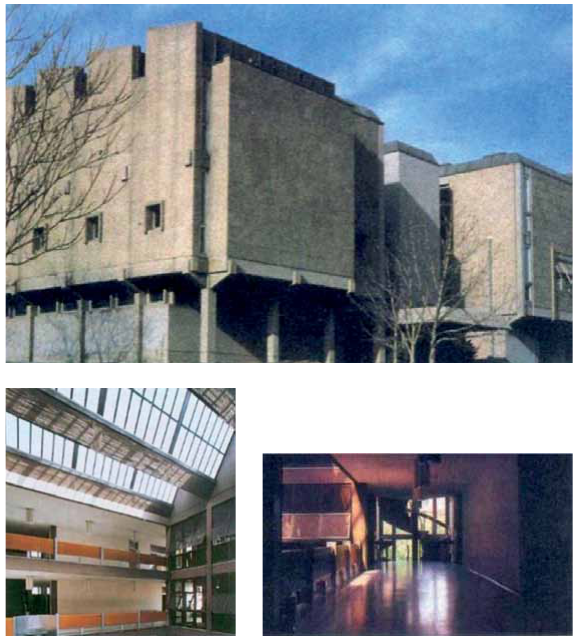
fig. 11. Turkish Historical Society Building